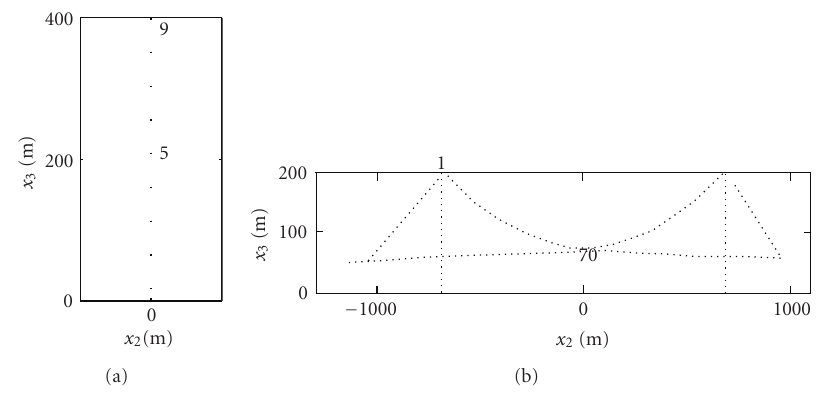
Figure 2: Grids for wind simulation: example 1 (a); example 2 (b).